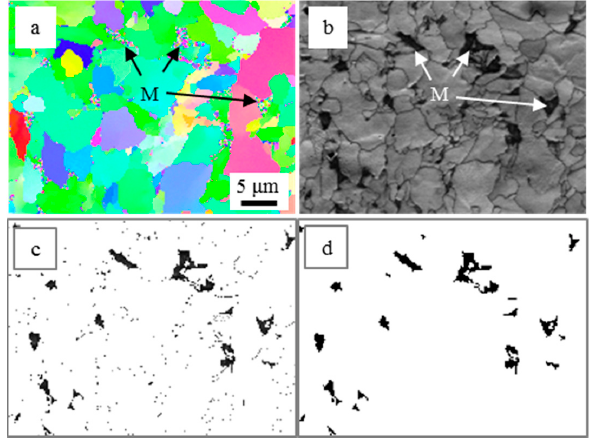
Figure 2. Example of electron backscatter diffraction (EBSD) analysis of martensite islands: ( a ) inverse pole figure (IPF) map; ( b ) index quality (IQ) map; ( c ) clusters of randomly-oriented points with low IQ values; and ( d ) clusters considered as martensite islands (>0.2 μ m 2 ) excluding grain boundary points.